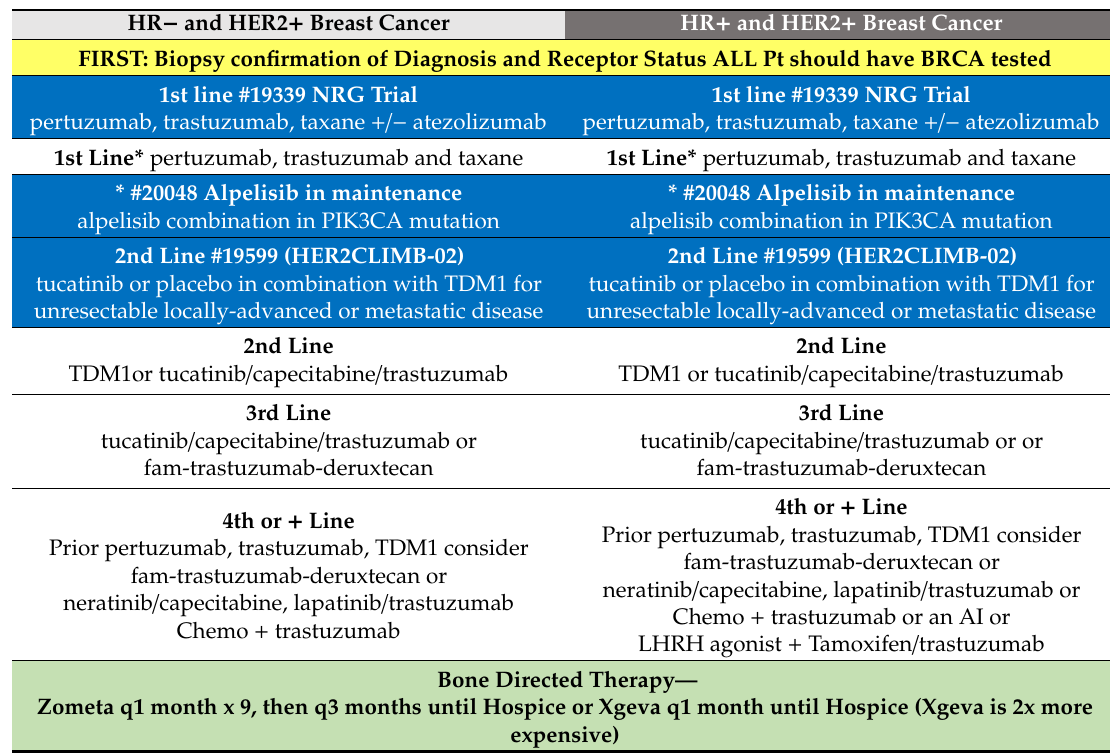
Table 1. City of Hope Institutional guidelines HER2 + metastatic disease. HR − and HER2 + Breast Cancer HR + and HER2 + Breast